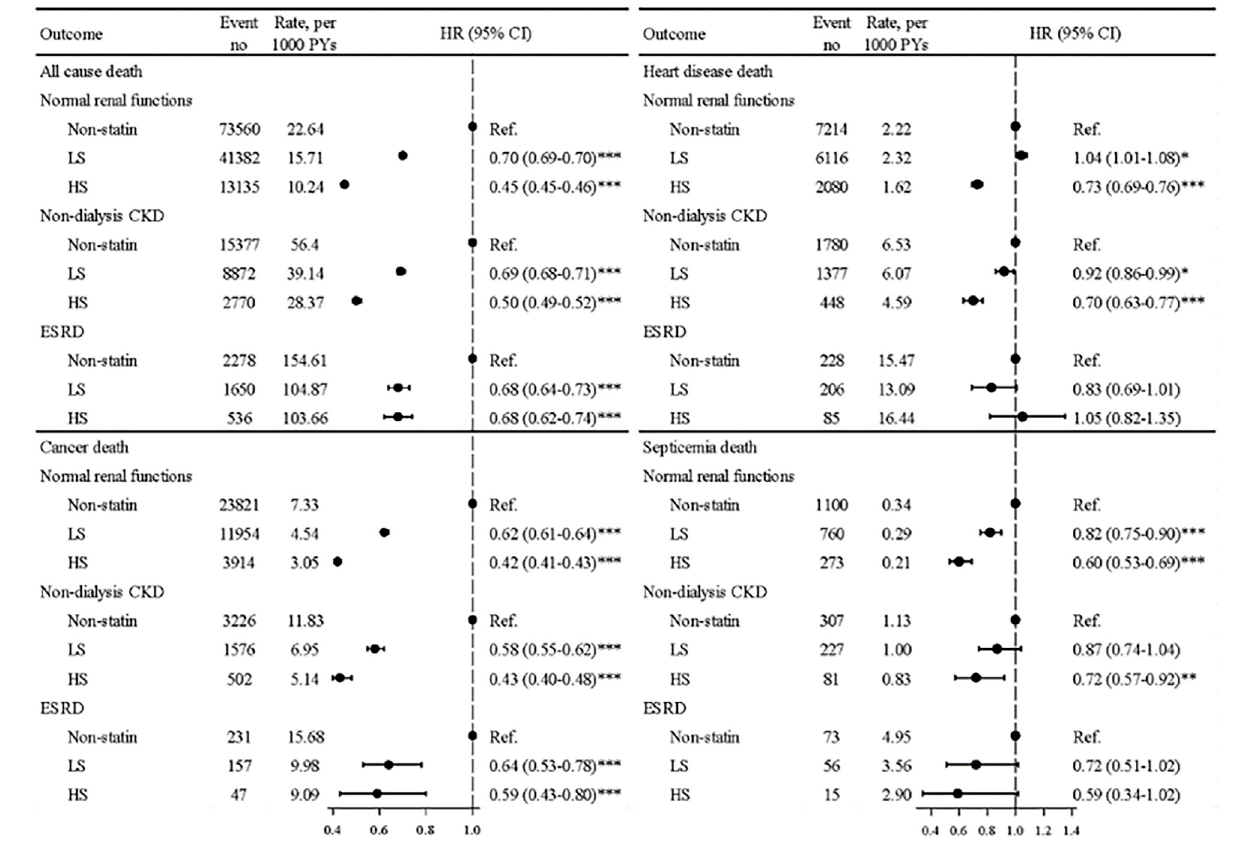
Frontiers in Pharmacology |